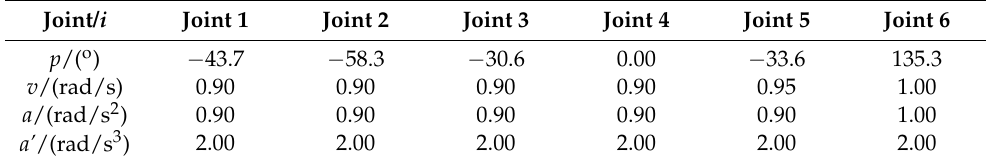
Table 4 . Joint kinematic constraints. Table 4. Joint kinematic